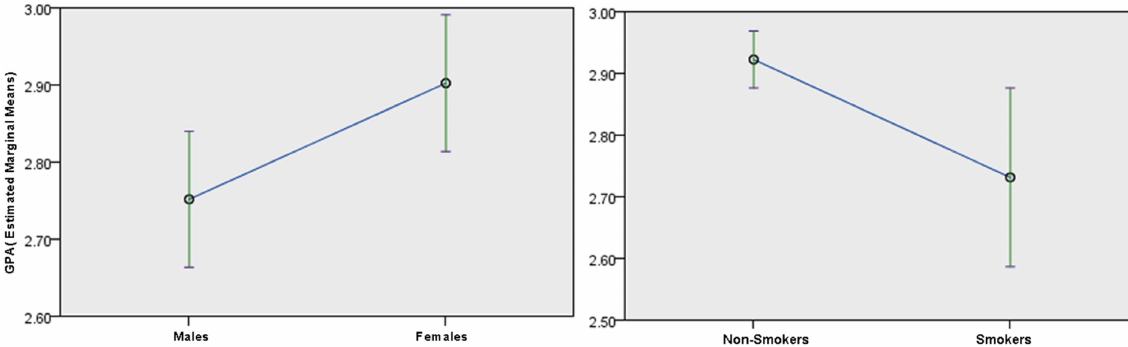
Fig 3. Mean plots of GPA (estimated marginal means) across gender and smoker groups. Error bars across means represent 95% confidenceinterval limits.